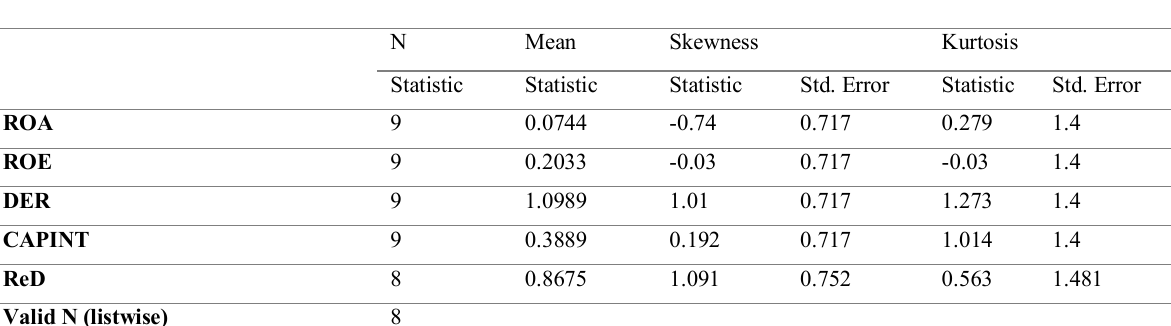
Table 3: Skewness and